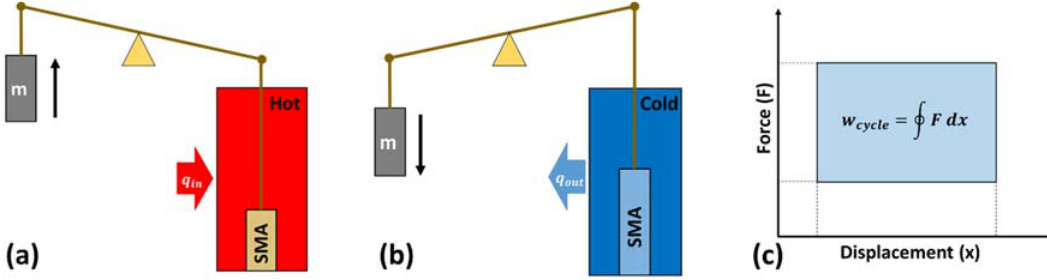
Figure 22. A simplistic conceptual model of a thermoelastic heat engine ( a ) heat absorption process ( b ) heat rejection process ( c ) force-displacement cycle.